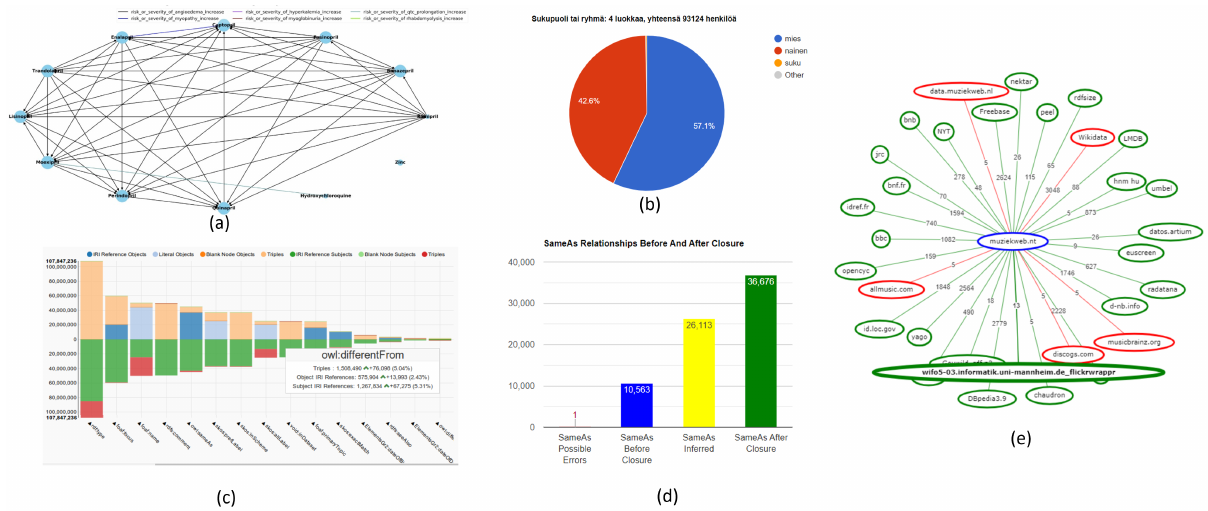
Figure 9. Indicative Screenshots of Visualization of analytical results for Categories C3-C5: ( a ) graph chart (C3), ( b ) pie chart (C3), ( c , d ) bar charts (C4,C5), ( e ) graph chart